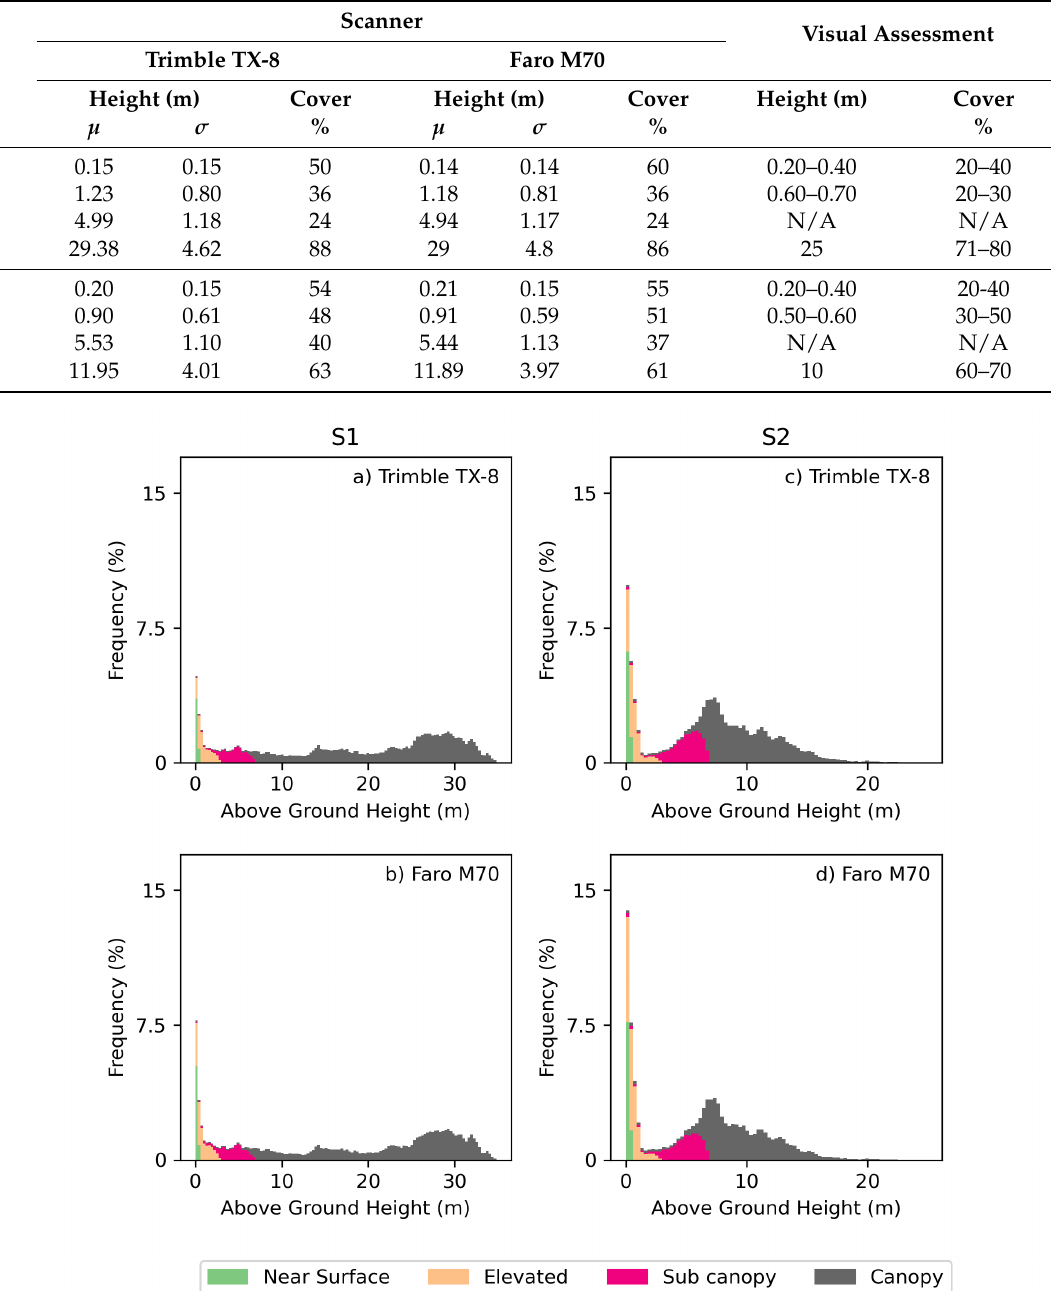
Figure 3. Above ground height distribution of filled voxels from the respective fuel layers within S1 ( a , b ) and S2 ( c , d ) plots captured by the Trimble TX-8 and Faro M70 scanners. Space originating from near surface is is shown in blue, elevated fuel in orange, sub-canopy in green and canopy in